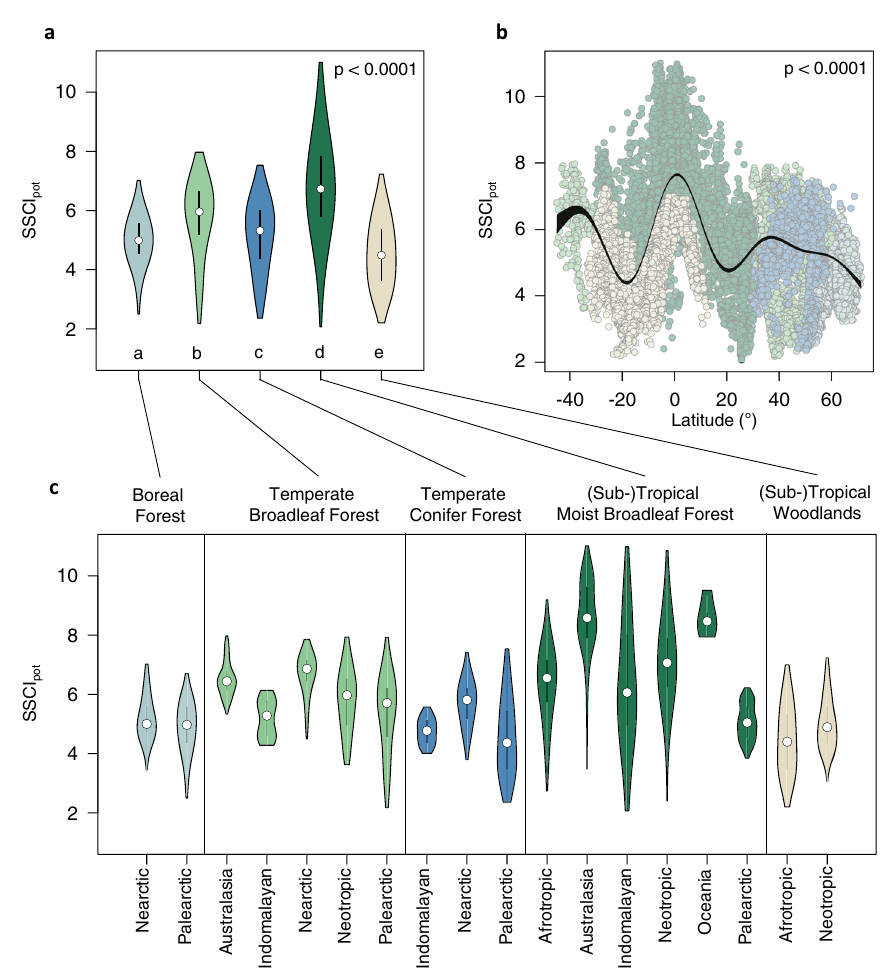
Fig. 3 Global variability and latitudinal patterns of the potential structural complexity. Globally modeled forest structural complexity (SSCI pot ), expressing the potential structural complexity across and within biomes ( a ), latitudes ( b ), and realms ( c ). Data points ( n = 21,851) are samples based on a systematic global sampling grid with a distance of 50 km between points. Letters in a indicate signi fi cant differences in SSCI pot between biomes (one-way ANOVA, Tukey HSD post-hoc test, p < 0.0001). White dots mark the median, black lines the interquartile range and colored violins the probability density of the underlying distribution. The black band in b represents the 95% con fi dence interval of a thin-plate regression spline based on a generalized additive model ( p <